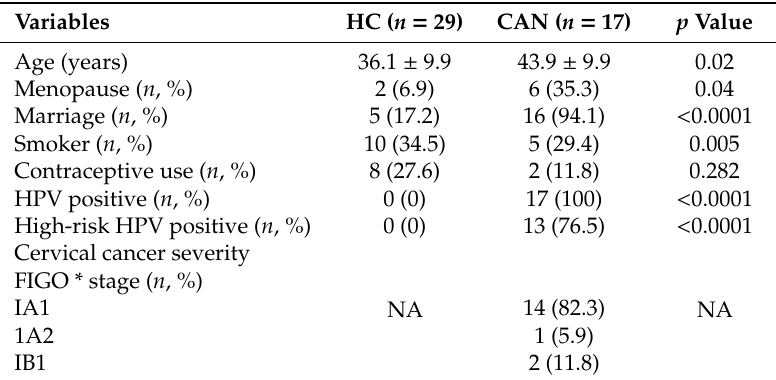
Figure 2. The α- and β-diversity of fecal microbiota by group (HC vs. CAN). ( A ) Significant differences in Chao1 and observed OTUs were observed between each group ( p = 0.0098 and p = 0.012). No significant difference was observed between HC and CAN regarding Shannon’s index. ( B ) Principal coordinates analysis (genus level) using the Bray–Curtis dissimilarity, displaying the dissimilarities of fecal microbiota between each group. 2.3. Comparative Analysis of the Fecal Microbial Taxa between HC and CAN Assigned sequences were used to evaluate differences in taxonomic abundances between CAN and HC at various taxonomic levels. We observed significant changes in fecal microbiota structures between HC and CAN. At the phylum level, the abundance of Bacteroidetes, Firmicutes, and Proteobacteria did not reach statistical significance (data not shown). At the family level, the abundance of Lachnospiraceae ( p = 0.001) and Turicibacteraceae ( p = 0.0017) in HC was significantly higher, whereas the abundance of Tissierellaceae ( p = 0.001), Prevotellaceae ( p = 0.001), and Actinomycetaceae ( p = 0.0023) was higher in CAN (Figure S1). At the genus level, Prevotella ( p = 0.0022) was notably more abundant in CAN. While Unclassified Lachnospiraceae ( p = 0.0022) and Clostridium ( p = 0.0035) were more abundant in HC. Other genera, namely Finegoldia , Anaerococcus , Peptostreptococcus , Peptoniphilus , Varibaculum , Parvimonas , and Dialister were enriched in the CAN group, and the difference was statistically significant (Figure 3). Linear discriminant analysis effect size (LEfSe) analysis was performed to compare the most differently abundant taxa of each group